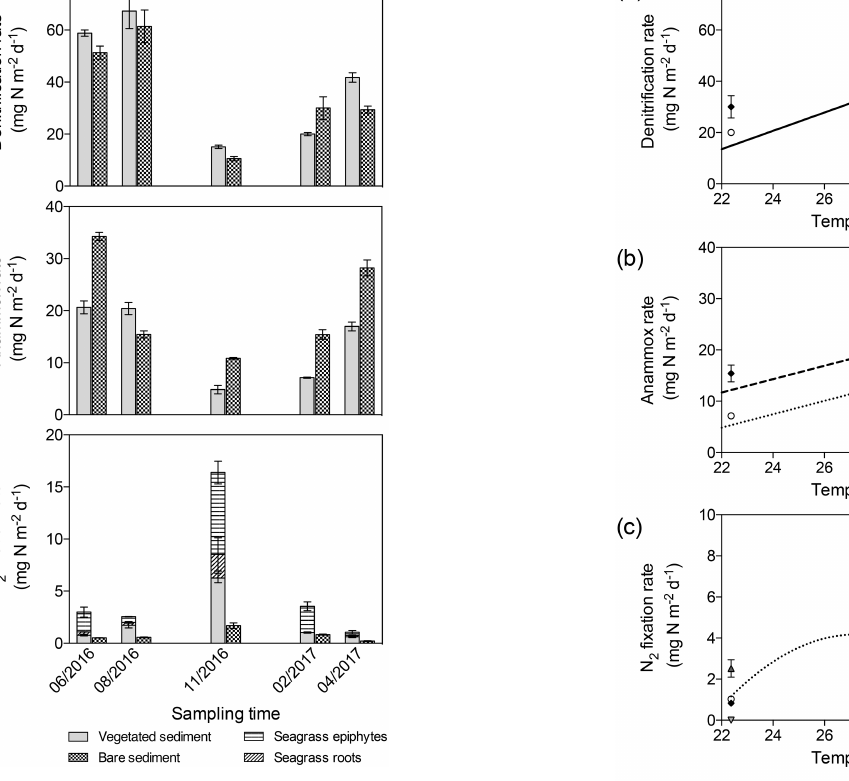
Figure 4. Area integrated sediment rates throughout the year. (a) Denitrification rates in vegetated (gray) and bare (square pattern) sediments. (b) Anammox rates in vegetated (gray) and bare (square pattern) sediments. (c) N 2 fixation rates in vegetated (gray) and bare (square pattern) sediments, in seagrass roots (angled stripes), and epiphytes (horizontal stripes). Error bars indicate SEM.